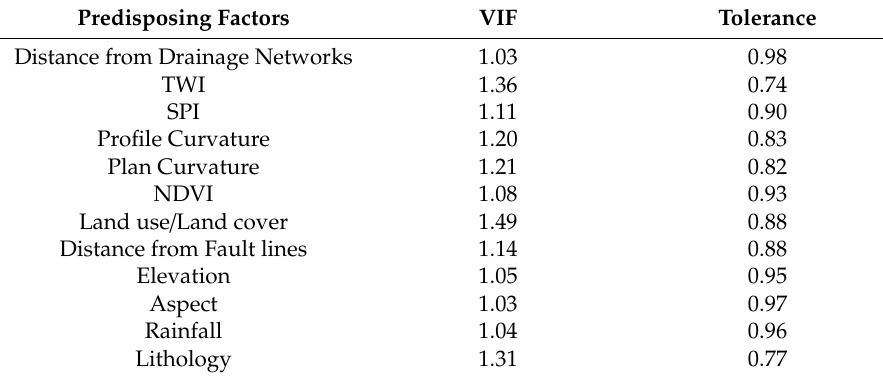
Table 5. Collinearity